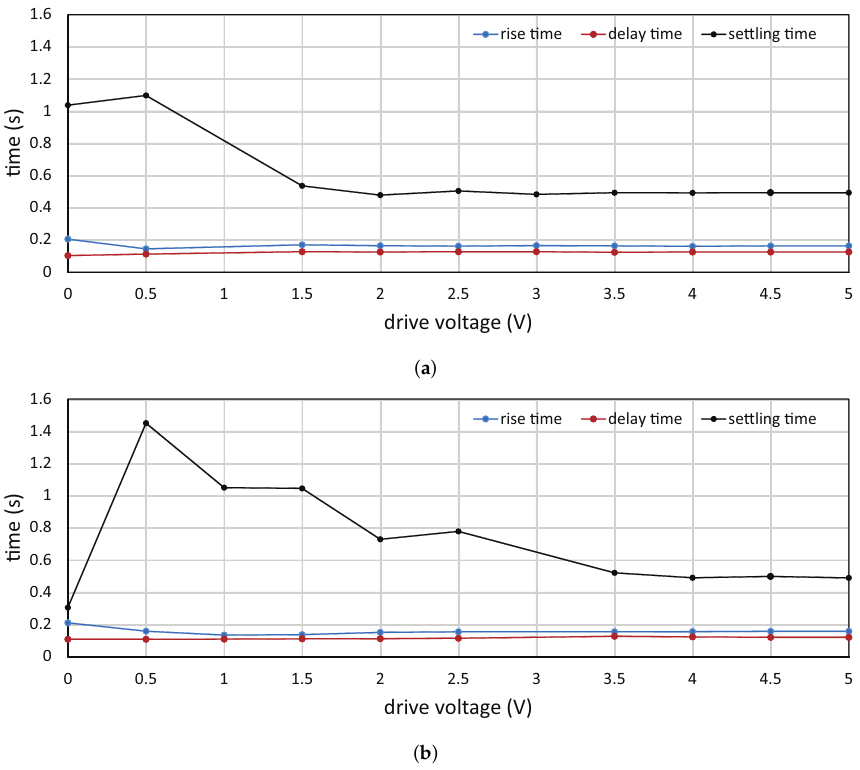
Figure 12. Dynamic response parameters of vibration amplitude: ( a ) 1 V; ( b ) 3